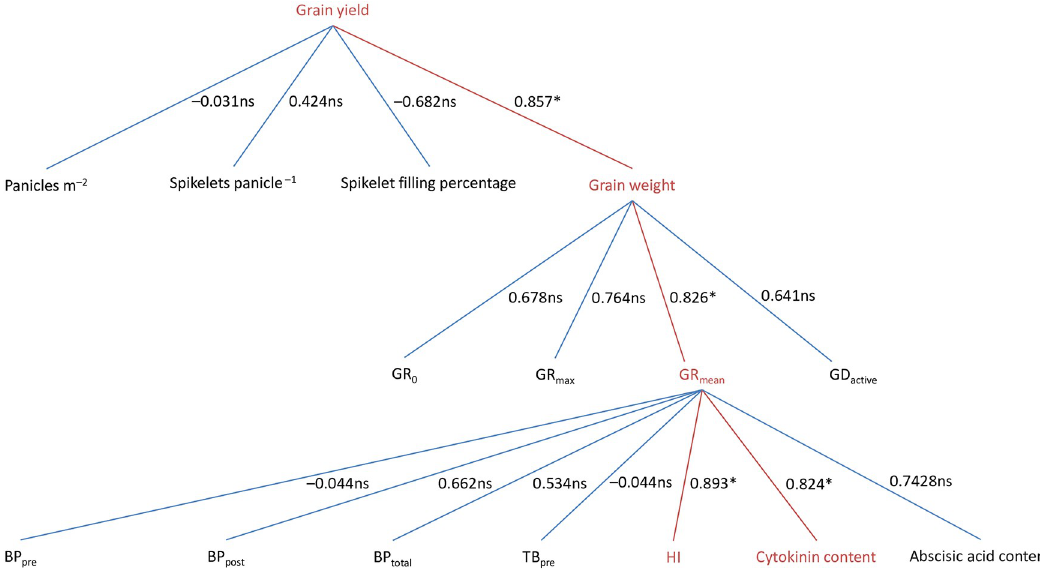
Fig 4. Pearson’s correlation coefficients between grain yield, yield components, grain-filling characteristics, and source-sink traits in early-season rice. The data used for analysis are presented in Tables 1–3 and Fig 3. ns and � denote non-significant and significant, respectively, at the 0.05 probability level ( n = 6). GR 0 , initial grain-filling rate; GR max , maximum grain-filling rate; GR mean , mean grain-filling rate; GD active , active grain-filling duration; BP pre , pre-heading biomass production per spikelet; BP post , post-heading biomass production per spikelet; BP total , total biomass production per spikelet; TB pre , translocation of pre-heading biomass to each spikelet; HI, harvest